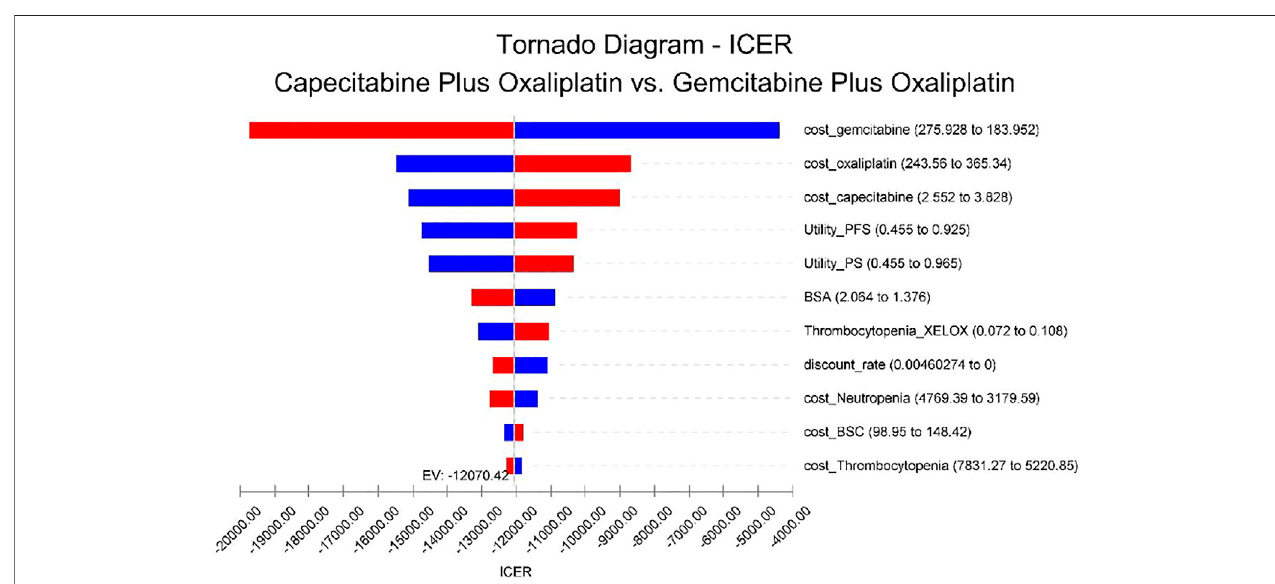
FIGURE 2 | Univariate sensitivity analysis. The tornado plots show the ICER of the XELOX therapy versus the GEMOX therapy for different input parameters in the model. The horizontal axis of the fi gure represents the range of in fl uence of each element on the results, and the vertical axis shows the name of each uncertainty factor. Thehorizontalbarsindicatethevalueoftheeffectofeachelementontheresultandthevalueoftheeffectofeachelementitself.TheeffectsofthefactorsontheICERare listed in descending order of signi fi cance. Abbreviations: EV, expected value; BSA, body surface area; BSC, best supportive care; PFS, progression-free survival; and PS, progression survival.